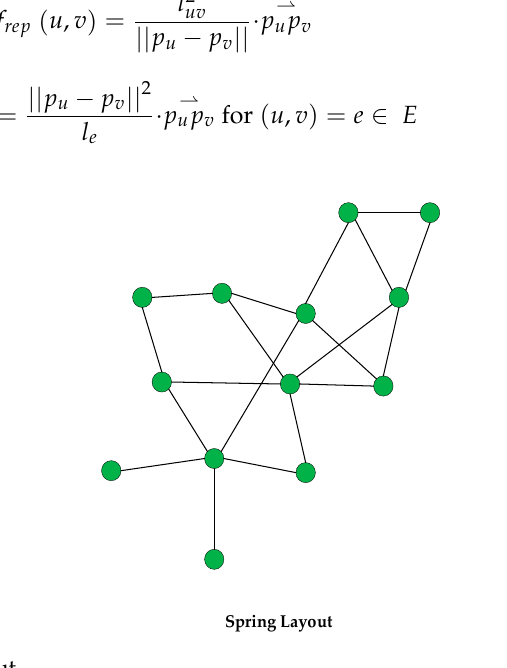
Figure 4. Random Layout and Spring